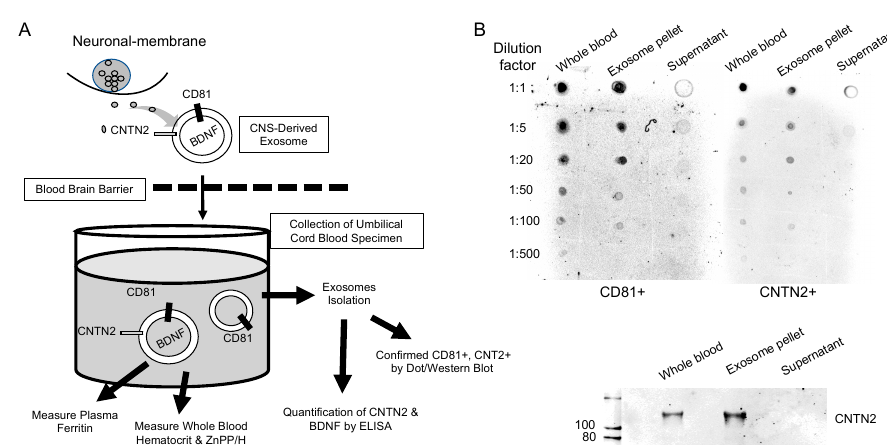
Figure 1. Flowchart of experimental study and validation of exosomal isolation. ( A ) Flowchart depicting methodology in brief. ( B ) Dot blot depicting qualitative levels of CD81 and CNTN2 within whole blood, the exosome pellet, and the supernatant. Bottom panel shows a Western blot image depicting qualitative levels of CNTN2 within those same three groups.